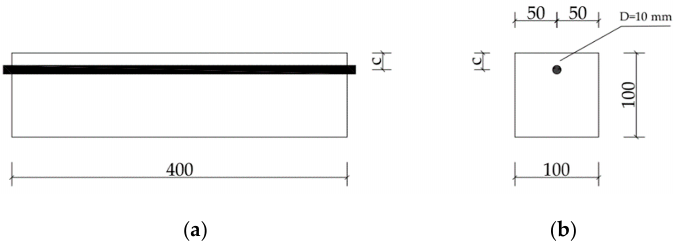
Figure 1. The geometry of the specimen and the positioning of reinforcement: ( a ) Front view; ( b ) Left view. c represents concrete cover thickness. Table 1. Mix proportions of concrete.